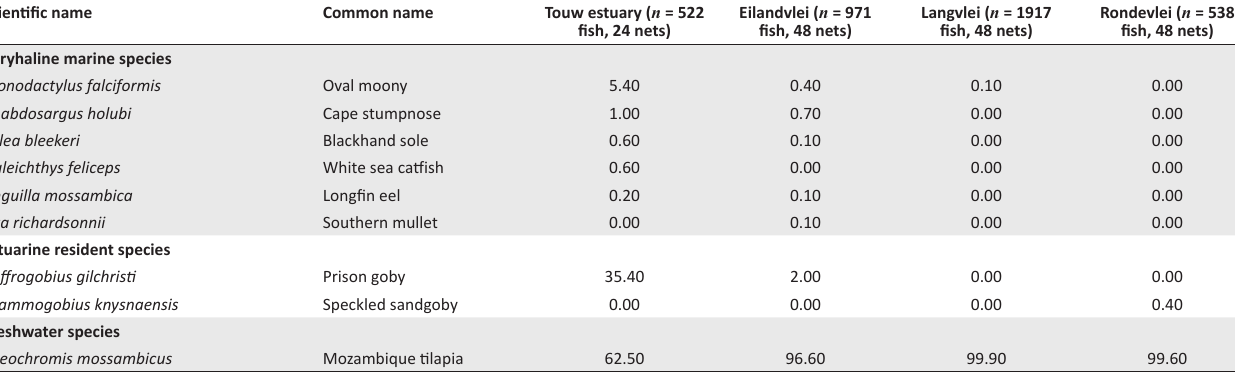
TABLE 2: Relative abundance ( % abundance) of fish species caught in fyke nets in the Wilderness Lakes System between April 2010 and January